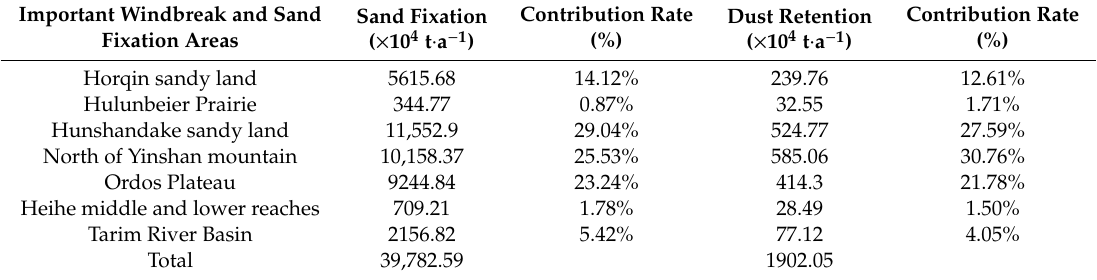
Table 6. Sand fixation and dust retention in seven important windbreak and sand fixation